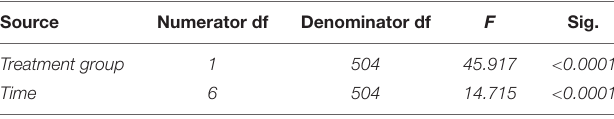
Frontiers in Ecology and Evolution |